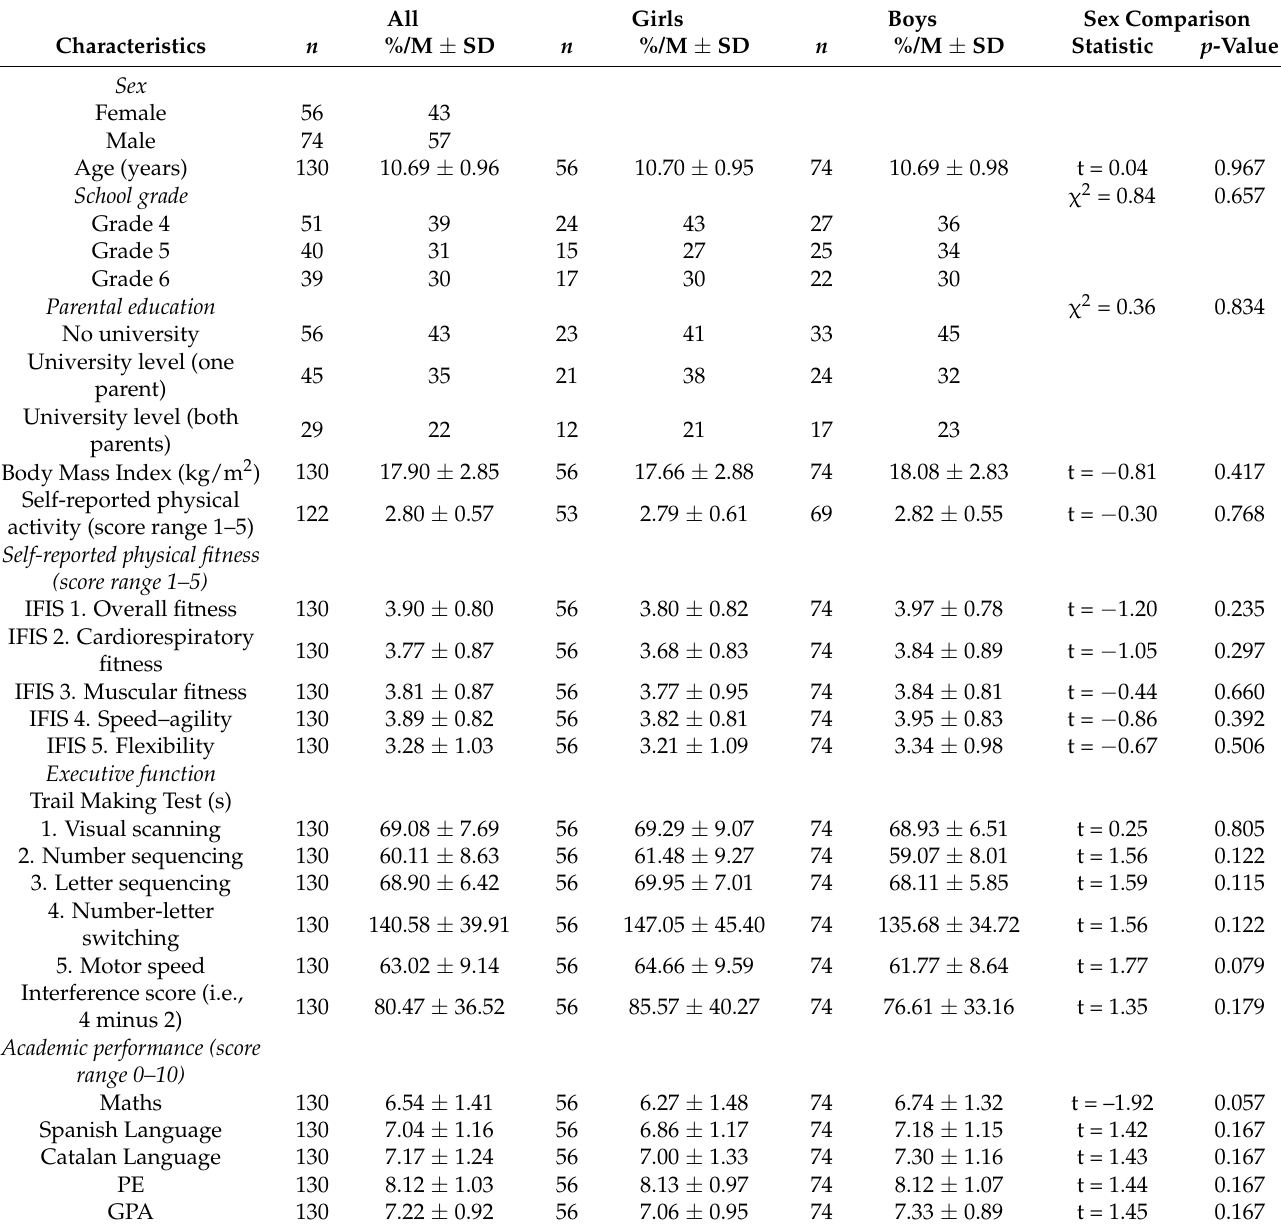
Table 1. Children’s demographic characteristics for the entire sample and divided by sex ( n =